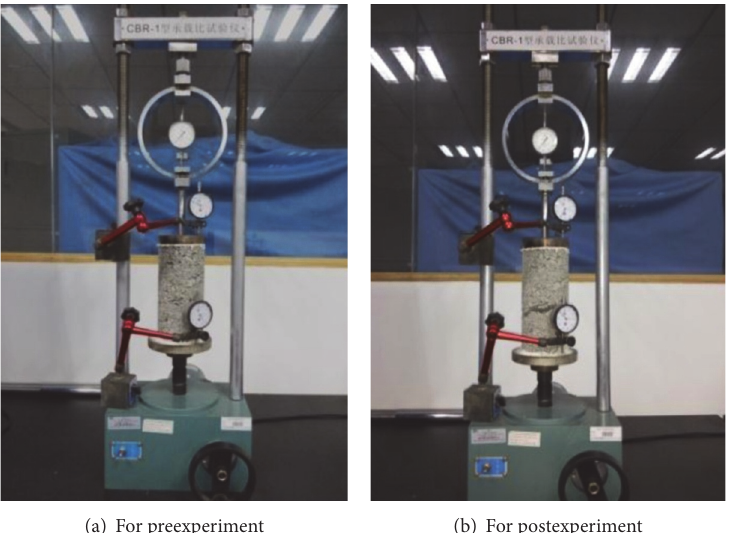
Figure 2: Direct tensile test using modified CBR.